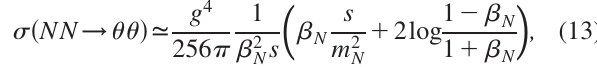
FIG. 2. The decay thermalization rate, (cid:4) curve), compared to the various scattering thermalization rates, = ð n eq H Þ for a ¼ W , Z , h , t , b ( the red, blue, green, orange (cid:4) a (cid:1) annih and purple curves, respectively), as a function of z ¼ m ¼ 120 GeV , m ¼ 2 : 8 MeV . For freeze-in these rates for m h (cid:1) remain always well below 1, which is the thermalization